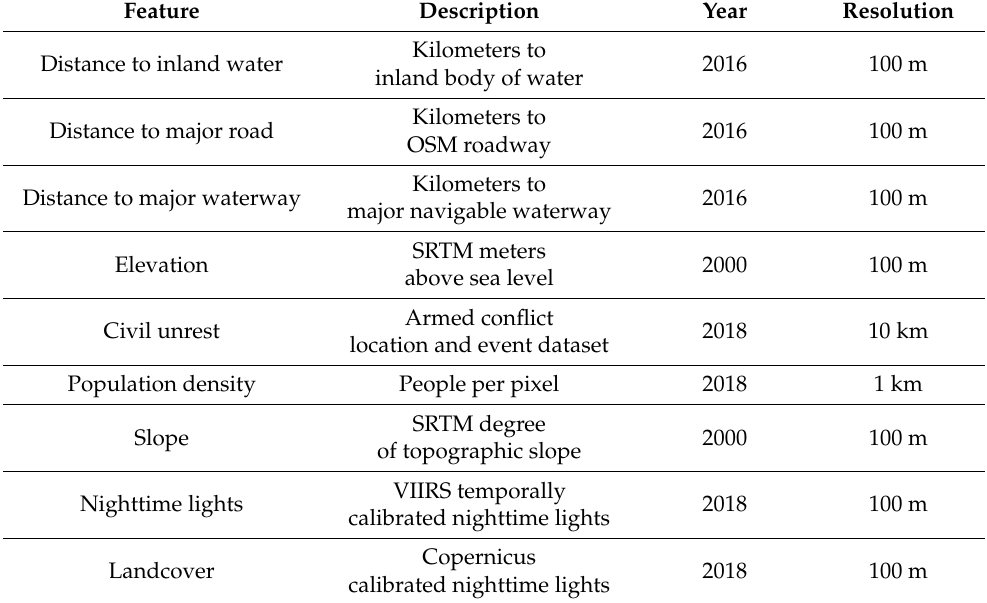
Table 1. Description of input features, the year they were collected, and original raster resolu- tion. All variables, accounting for various spatial resolutions, were aggregated and sampled via hexagonal grid-cells.